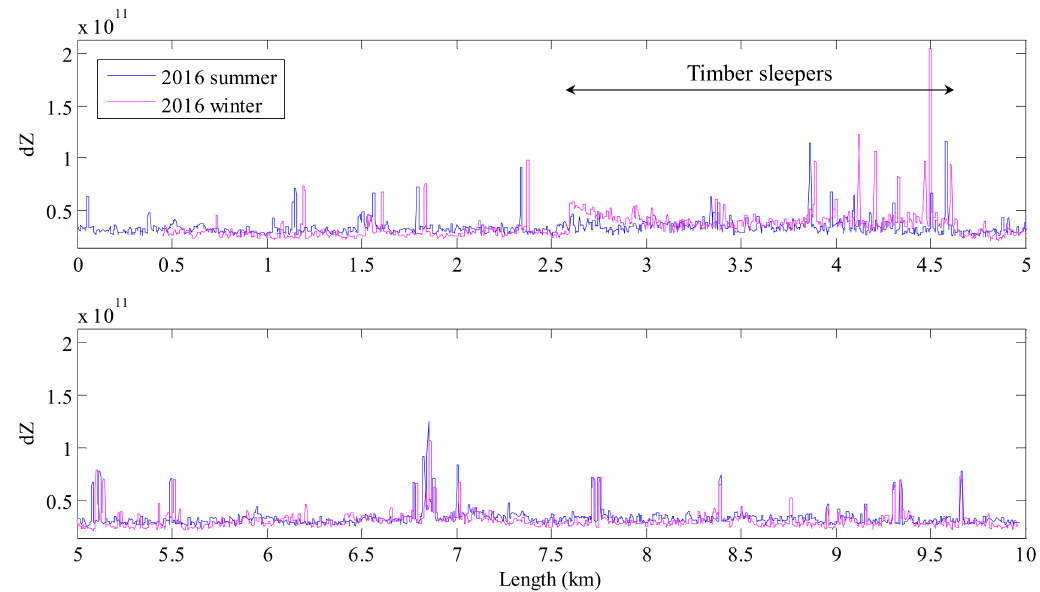
Figure 20. GPR parameter dZ , in the frequency domain, measured in January (winter) and in July (summer) of